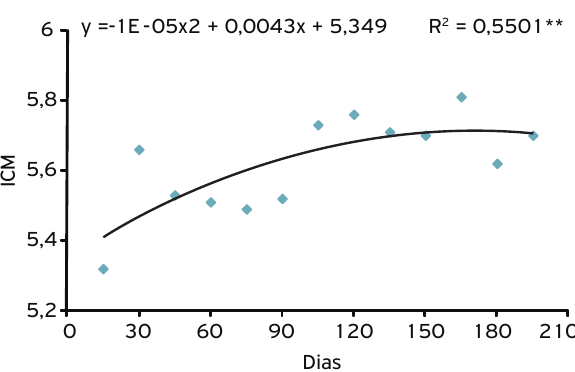
Figura 1. Crescimento micelial de A. niger imobilizado em alginato de sódio e armazenado em diferentes